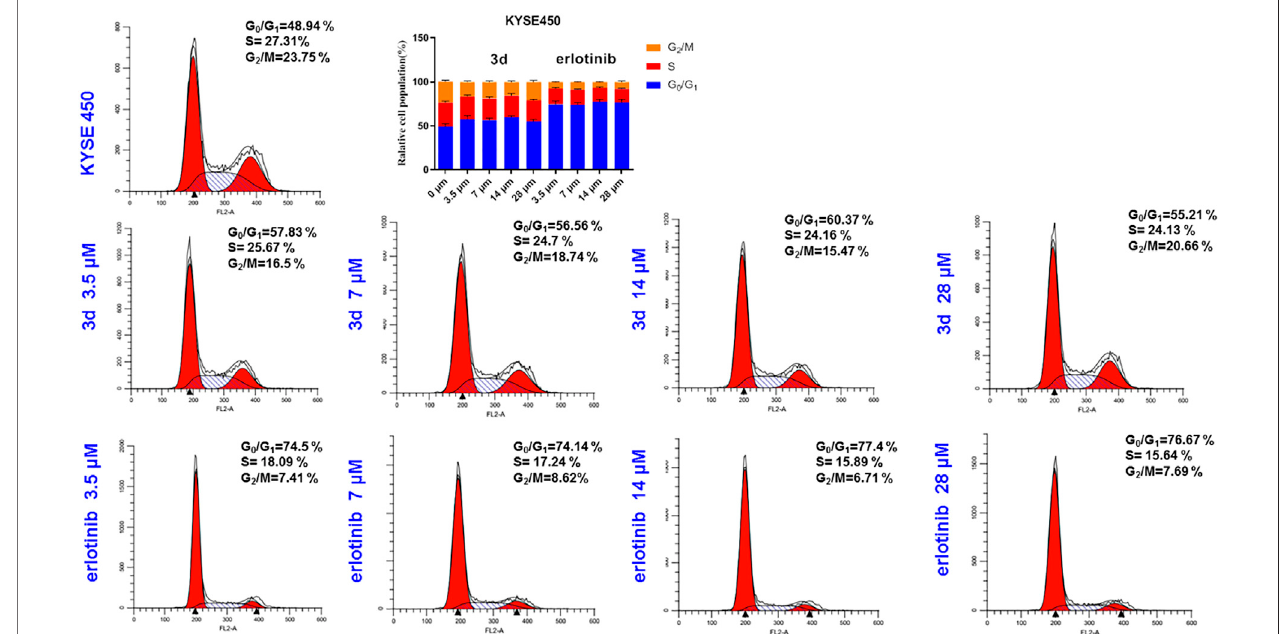
FIGURE 6 | KYSE450 cell cycle arrests induced by compound 3d and erlotinib in comparison with the cells treated with 0.1% DMSO.